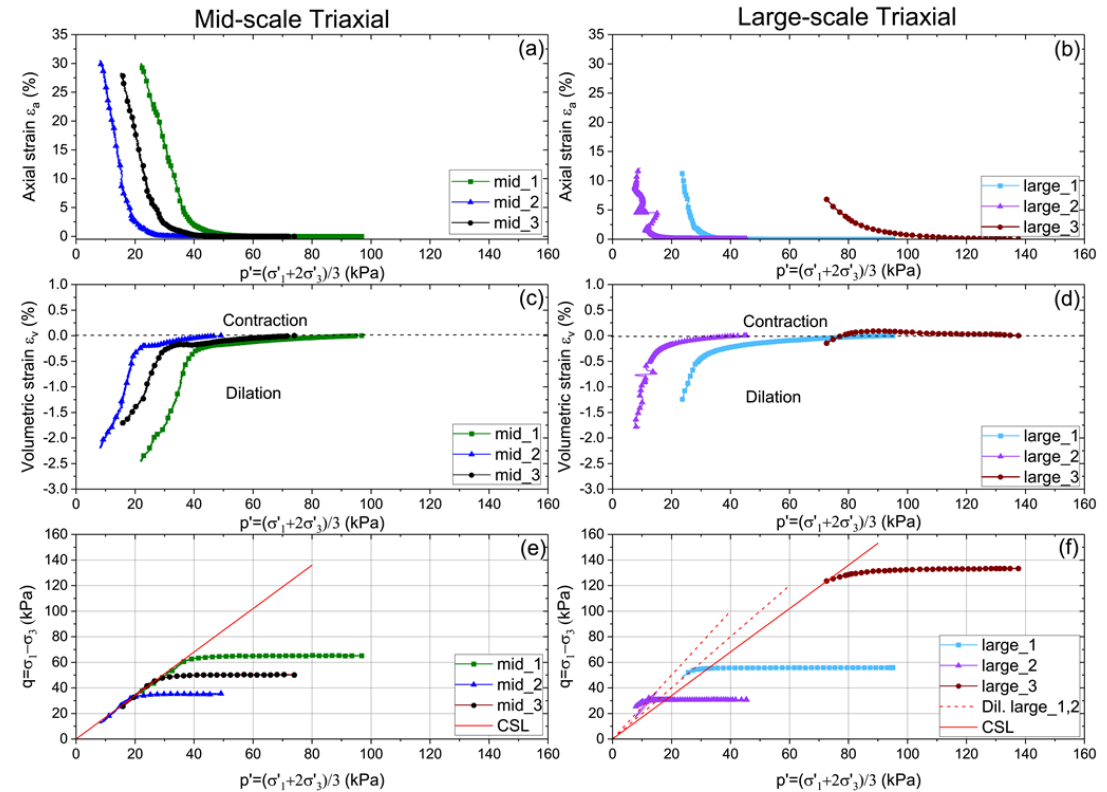
Figure 8. Constant shear stress drained test (CSD) results during shearing on gravelly scree soil (medium and large, with maximum particle size of 16 and 31.5 mm respectively). ( a , b ) axial strain versus mean e ff ective stress; ( c , d ) volumetric strain versus mean e ff ective stress; ( e , f ) mean e ff ective versus deviator stress at constant deviator stress and showing the stress path and critical state line (CSL). The mid-scale triaxial test is on the left, the large-scale on the right.